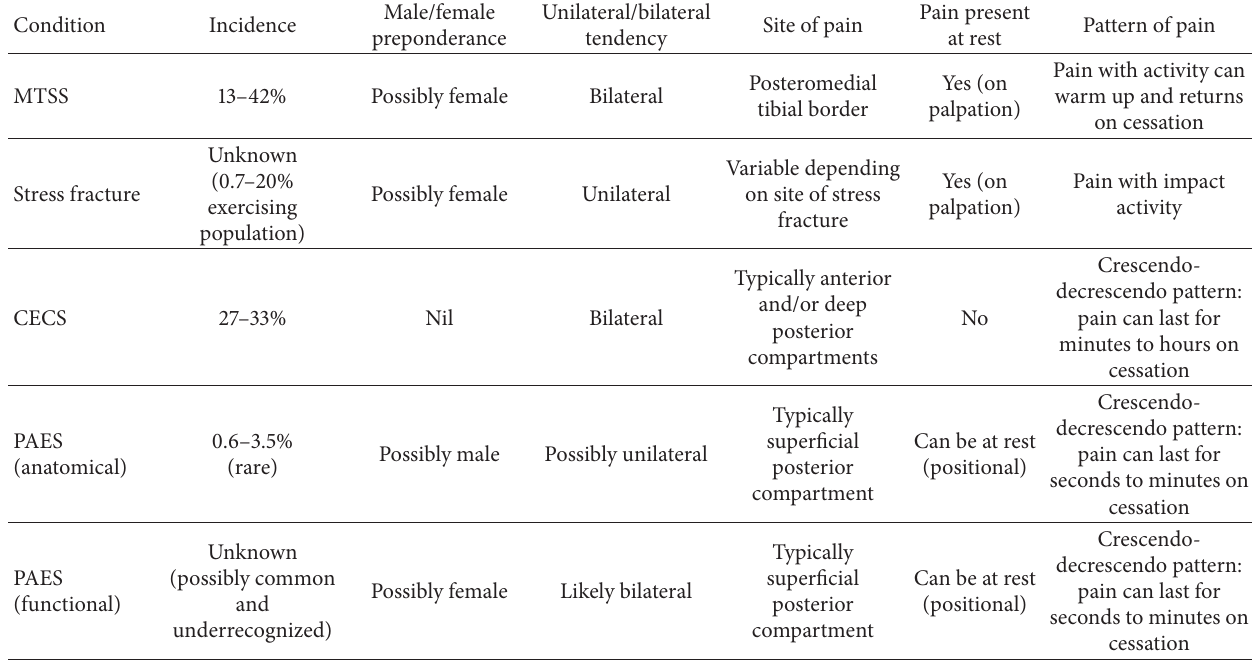
Table 1: Differential diagnosis and clinical features of exertional leg